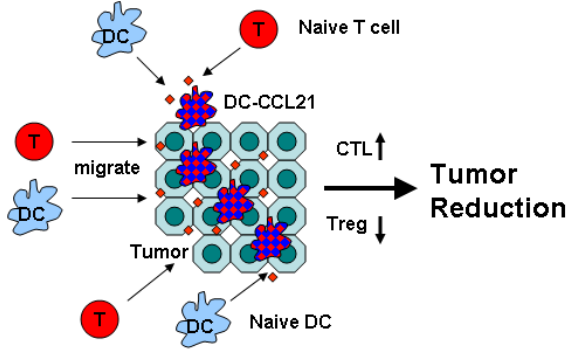
Figure 2. Mechanisms of DC-CCL21 Anti-Tumor Activity Intratumoral administration of DC-CCL21 promotes chemo-taxis of naïve T cell and DC into the tumor and increases APC activity of DC leading to activation of cytotoxic T lymphocytes (CTL) but reducing activity of regulatory T cell (Treg) that culminate in tumor